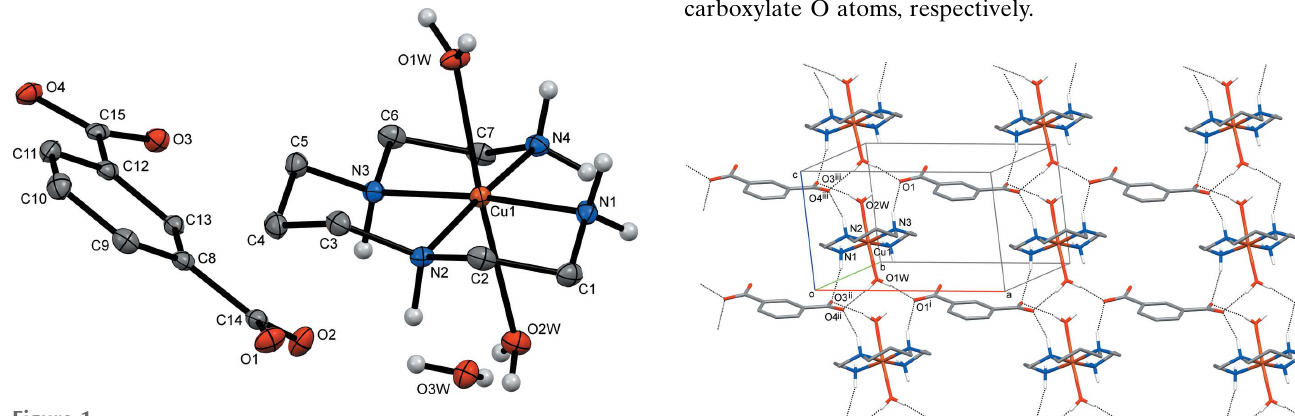
Figure 1 View of the asymmetric unit of I , showing the atom-labelling scheme, with displacement ellipsoids drawn at the 40% probability level. H atoms attached to carbon atoms have been omitted for clarity.